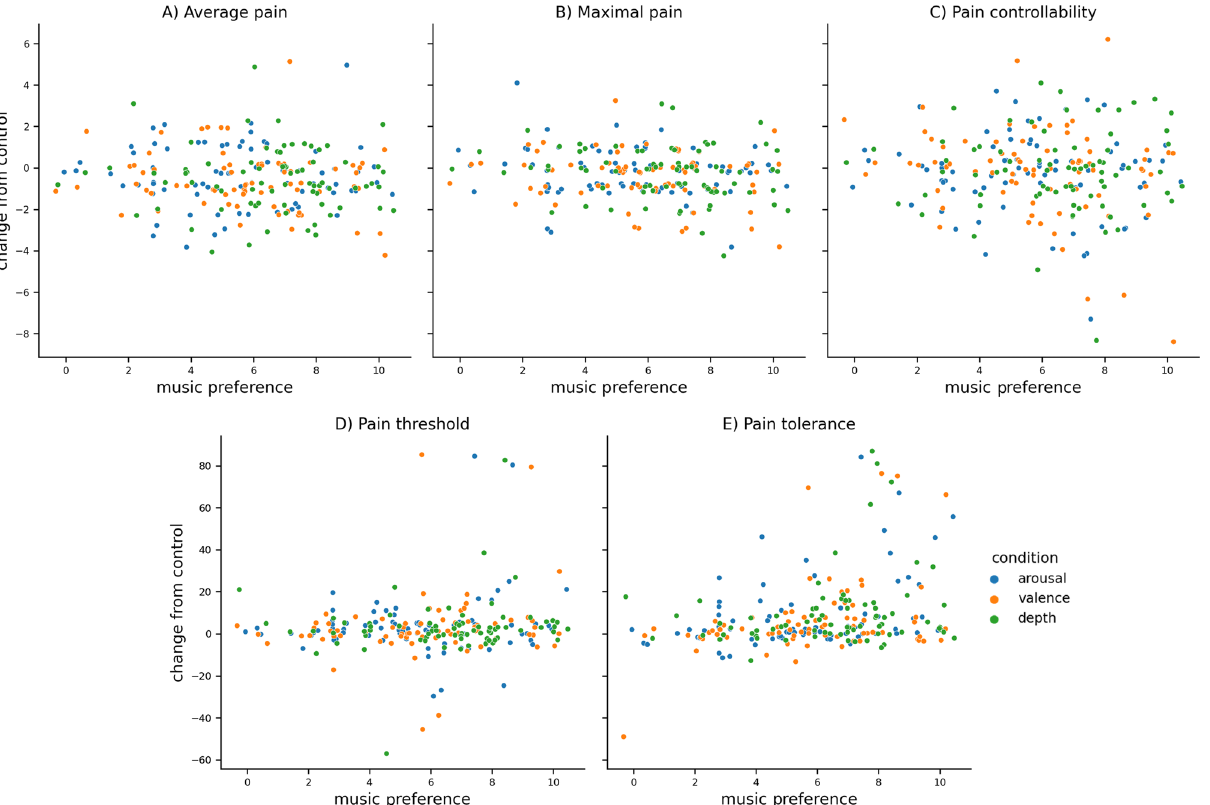
Figure 1. Pain outcomes as a function of music preference. Each data point represents one trial by one participant. Outcomes are reported as differences between one of three music conditions and the control condition. A value of 0 indicates no change from control. Random jitter was applied to all data points to facilitate the visualization of overlapping points. Presented outcomes are ( a ) average pain, ( b ) maximal pain, ( c ) pain controllability, ( d ) pain threshold, and ( e ) pain